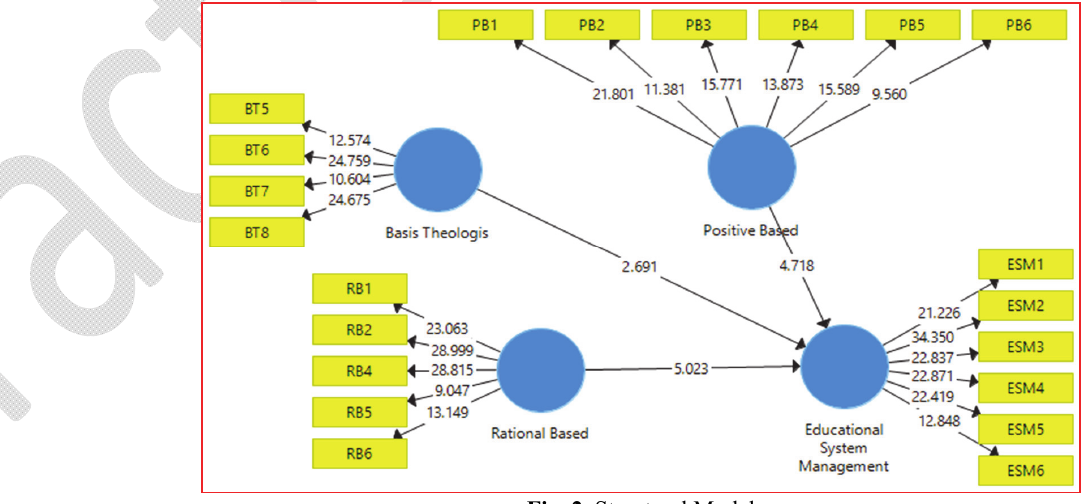
Original Sample